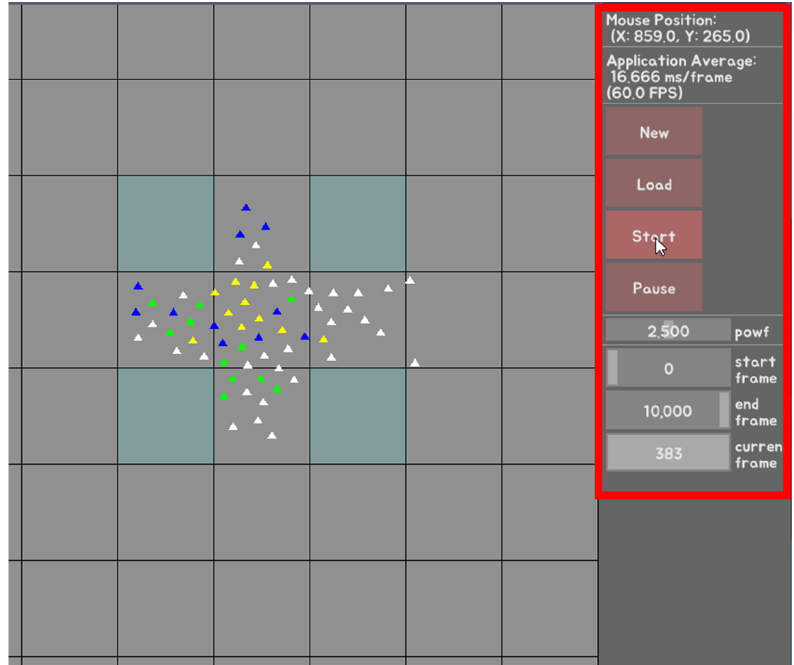
Figure 2. Graphic user interface (GUI) of crowd simulation in computer: All parameters for the simulation are set with widgets, such as sliders or buttons.